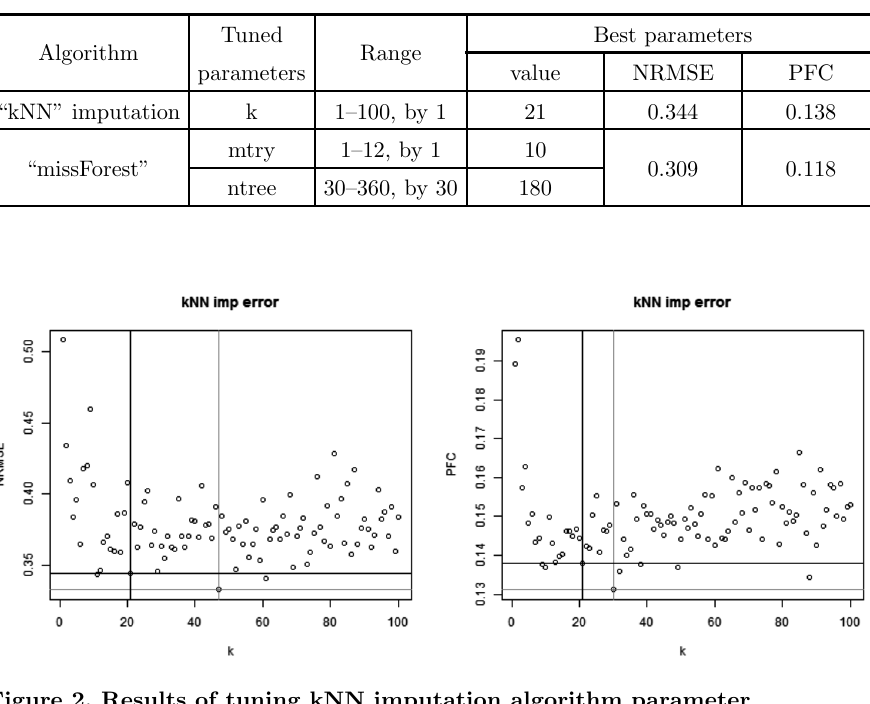
Figure 2. Results of tuning kNN imputation algorithm parameter